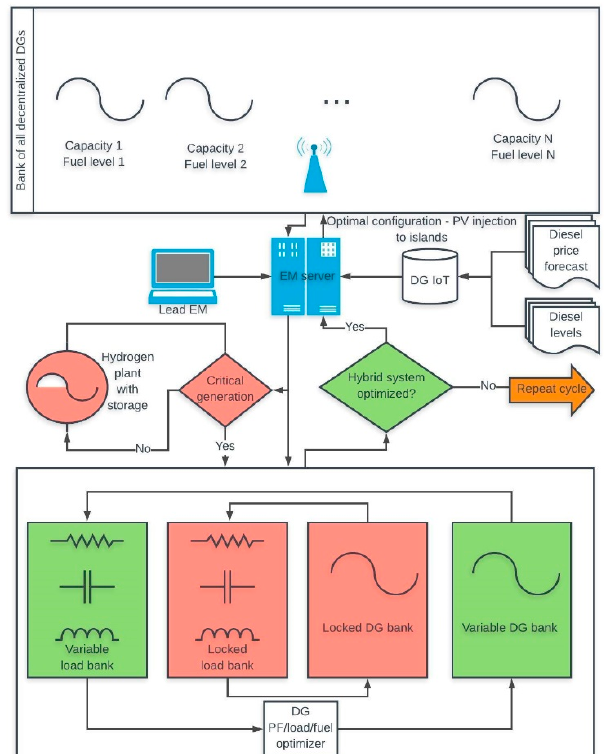
Figure 2. Optimization scheme to determine the variable/locked load banks to be fed to the diesel generator optimization scheme. This scheme depends on low-level departmental control and energy management policies.